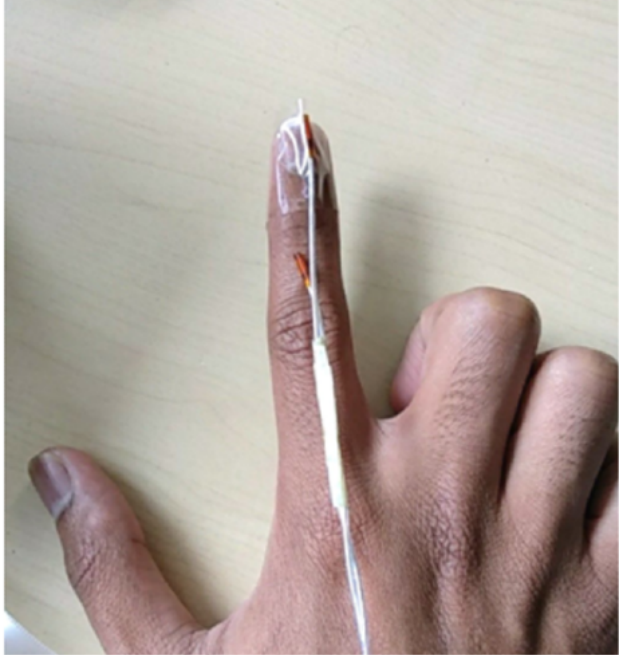
Figure 3. A Trakstar magnetic positioning sensor attached to the examining finger.